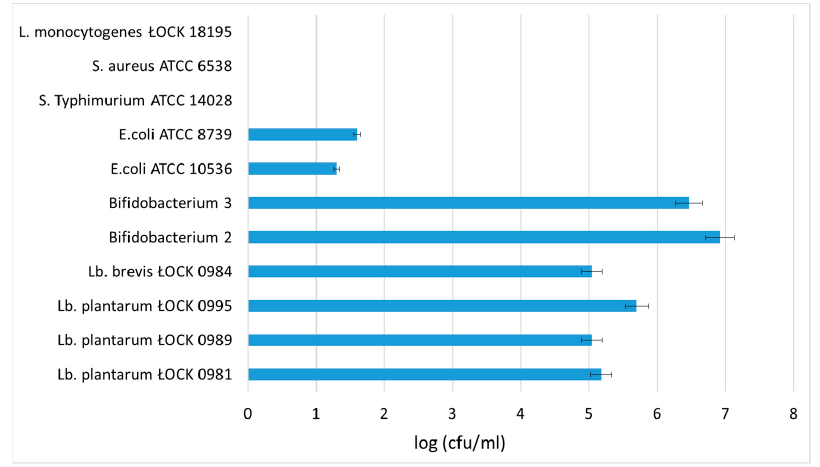
Figure 4. Cell growth of intestinal bacteria species determined after in vitro fermentation in SBP hydrolysate. The data represent means from three replicates in one experiment. Error bars denote SD. * Results significantly different from the control, ANOVA ( p < 0.05).